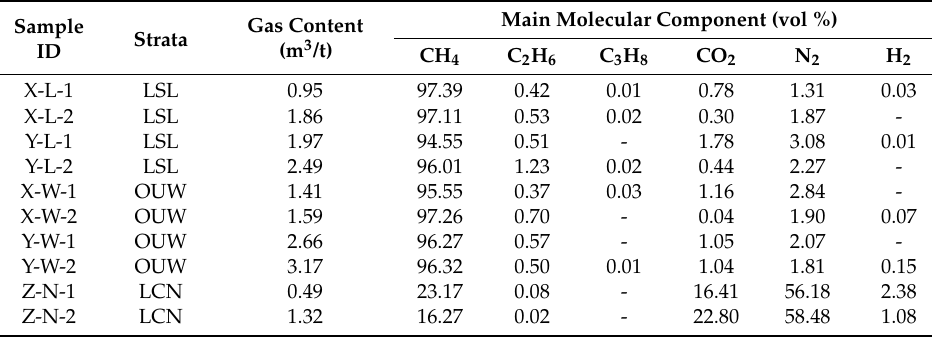
Table 2. In situ gas contents and gas components in the studied shales.